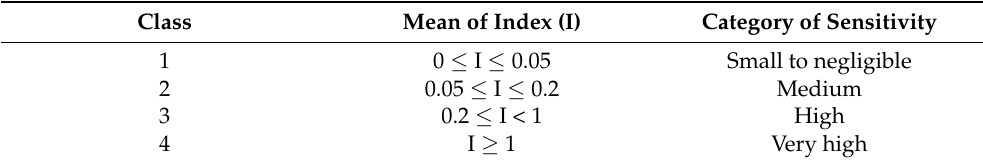
Table 2. Parameter sensitivity scale classes assigned in SWAT as adapted from Lenhart et al. (2002) [48]).